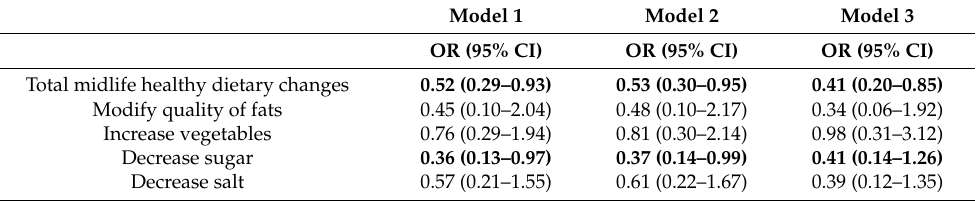
Table 3. The associations between midlife healthy dietary changes and late-life